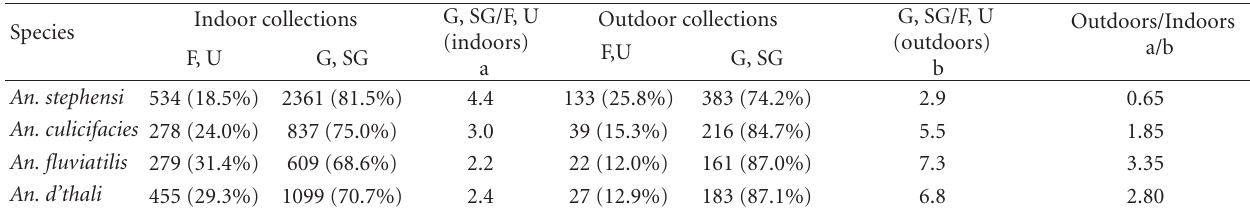
Table 2: Abdominal condition of female mosquitoes based on collecting sites in south and southeastern Iran.